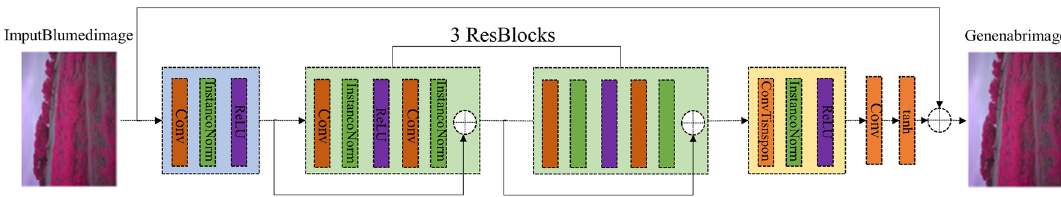
Figure 5. Structure of the generative adversarial network (GAN) 28,29 employed to sharpen blurred